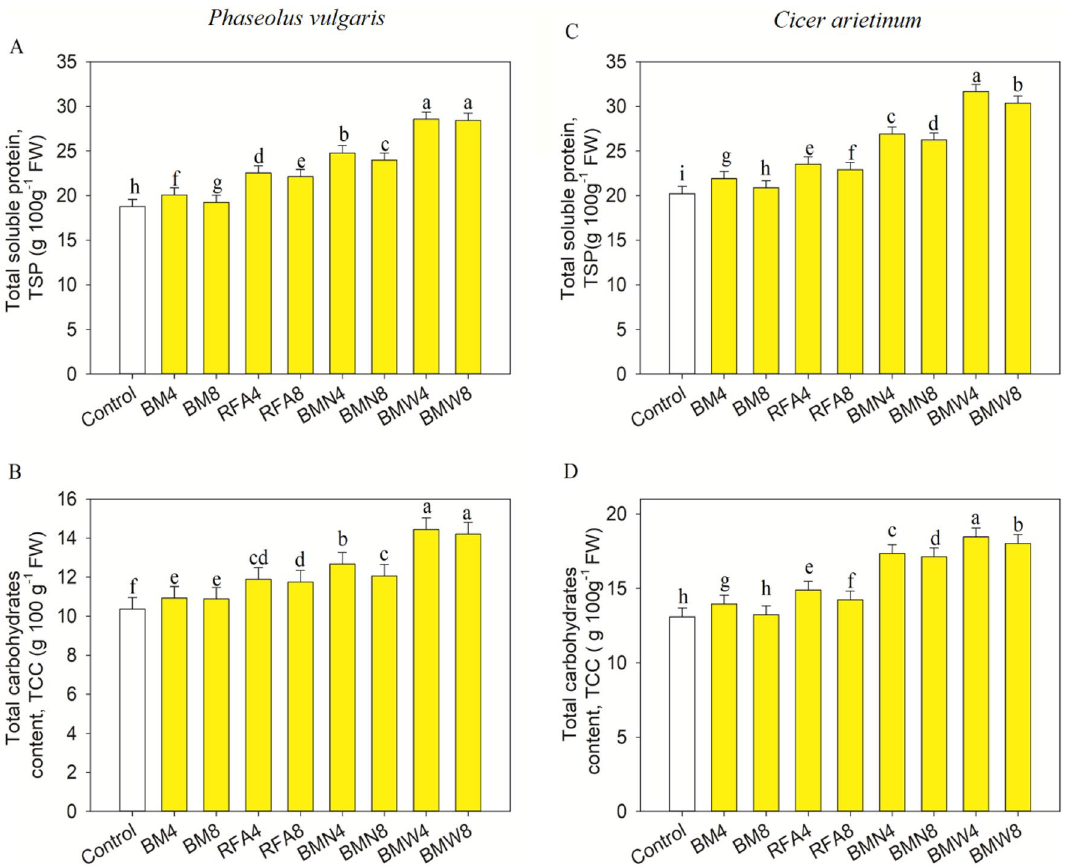
Figure 6. Impact of CNP treatment on the total soluble protein and total carbohydrate contents of Phaseolus vulgaris ( A,B ) and Cicer arietinum ( C,D ) seedlings. The bars represent the standard deviations (SD) of three replicates, and the different letters denote the treatment differences that are statistically